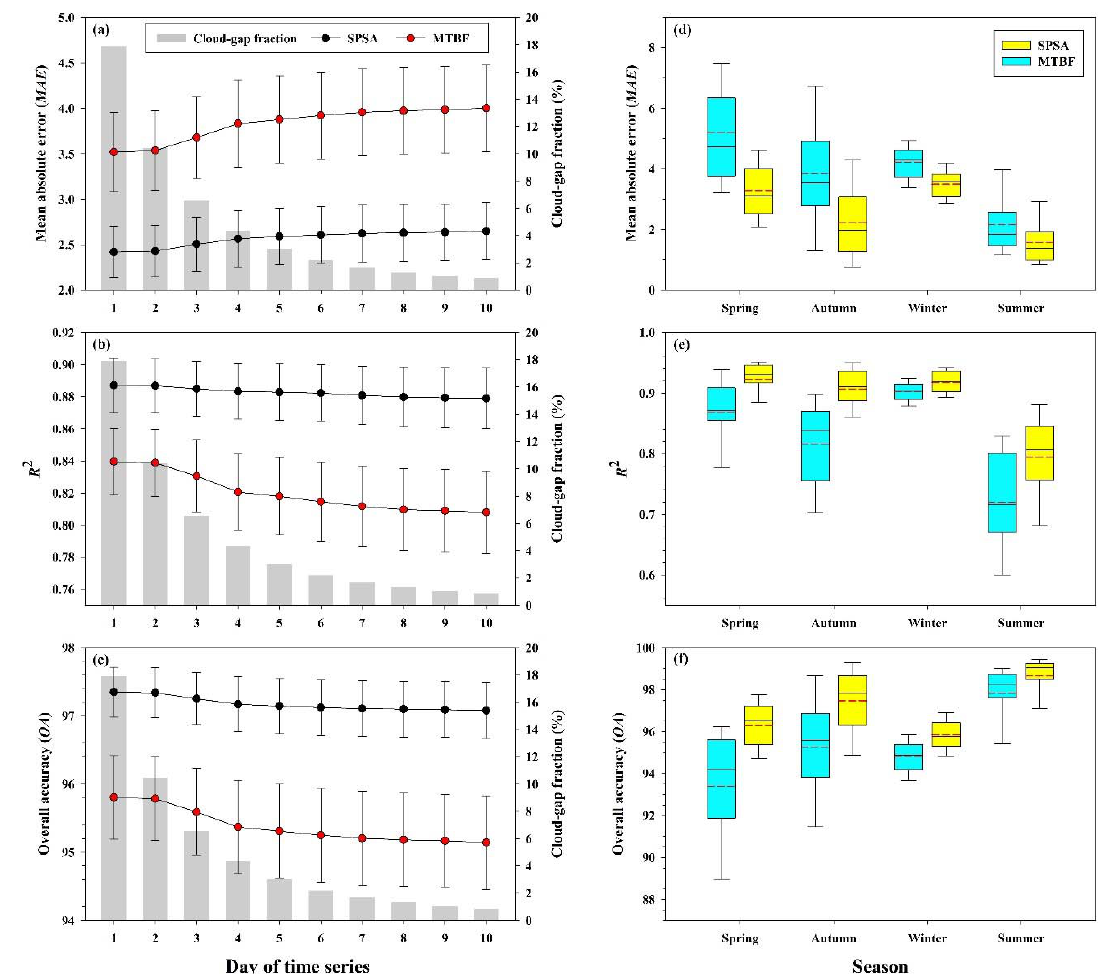
Figure 19. Comparison of the performance of the SPSA and multi-temporal backward filter (MTBF). ( a ), ( b ), and ( c ) show the temporal variations in MAE , R 2 , and OA , respectively, with the length of the temporal window. The whiskers show half of the standard deviation. ( d ), ( e ), and ( f ) show the accuracy indices of the SPSA and MTBF during different seasons. The top and bottom of each box are the 75th and 25th percentiles, respectively. The whiskers show the 5th (bottom) and 95th (top) percentiles. The horizontal line inside each box represents the median while the red dashed line inside each box is the mean.